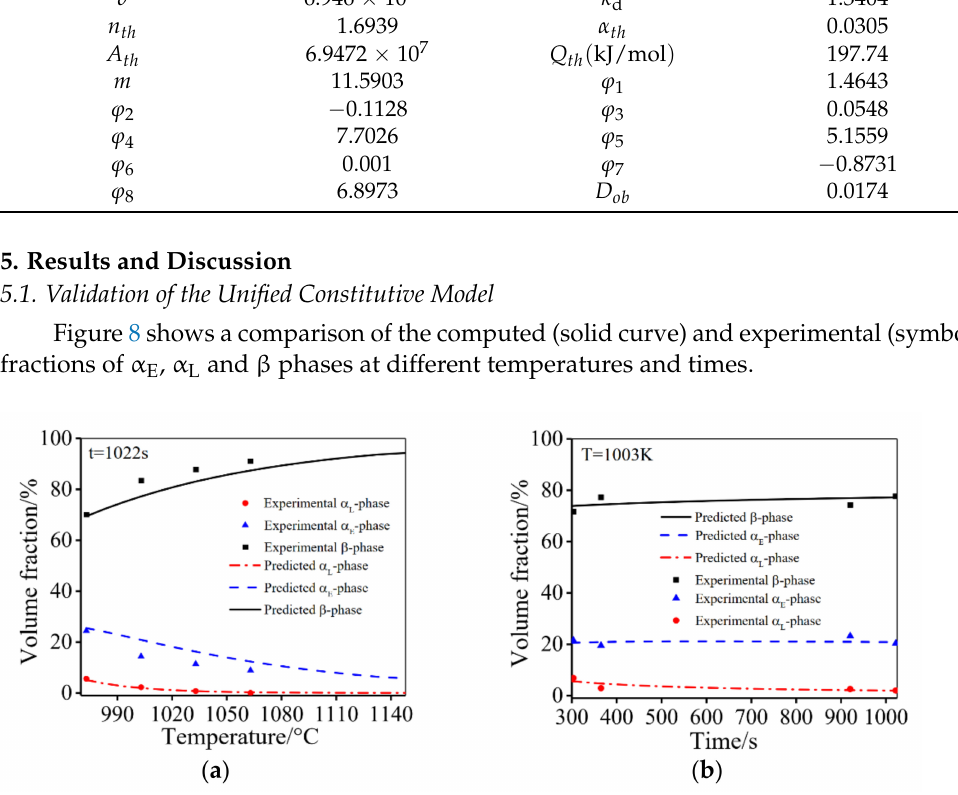
Figure 8. The volume fractions of α E , α L and β phases at different: ( a ) temperatures; ( b ) times. It is evident that there is a good agreement between the computed and experimental results. This indicates that the established model (Equation (27)) is effective. Figure 9 shows the experimental and predicted material parameters under different deformation conditions. A good consistency between the calculated and experimental material parame- ters is achieved. The evolution law of phase transformation, β subgrains, spheroidization fractions under different deformation condition are also consistent with the experimental results in Section